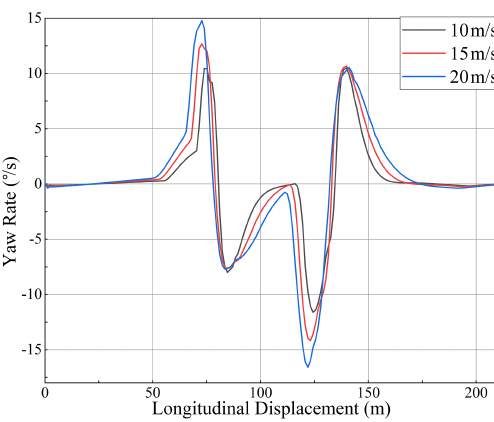
Figure 15. Steering angle of different friction coefficients.